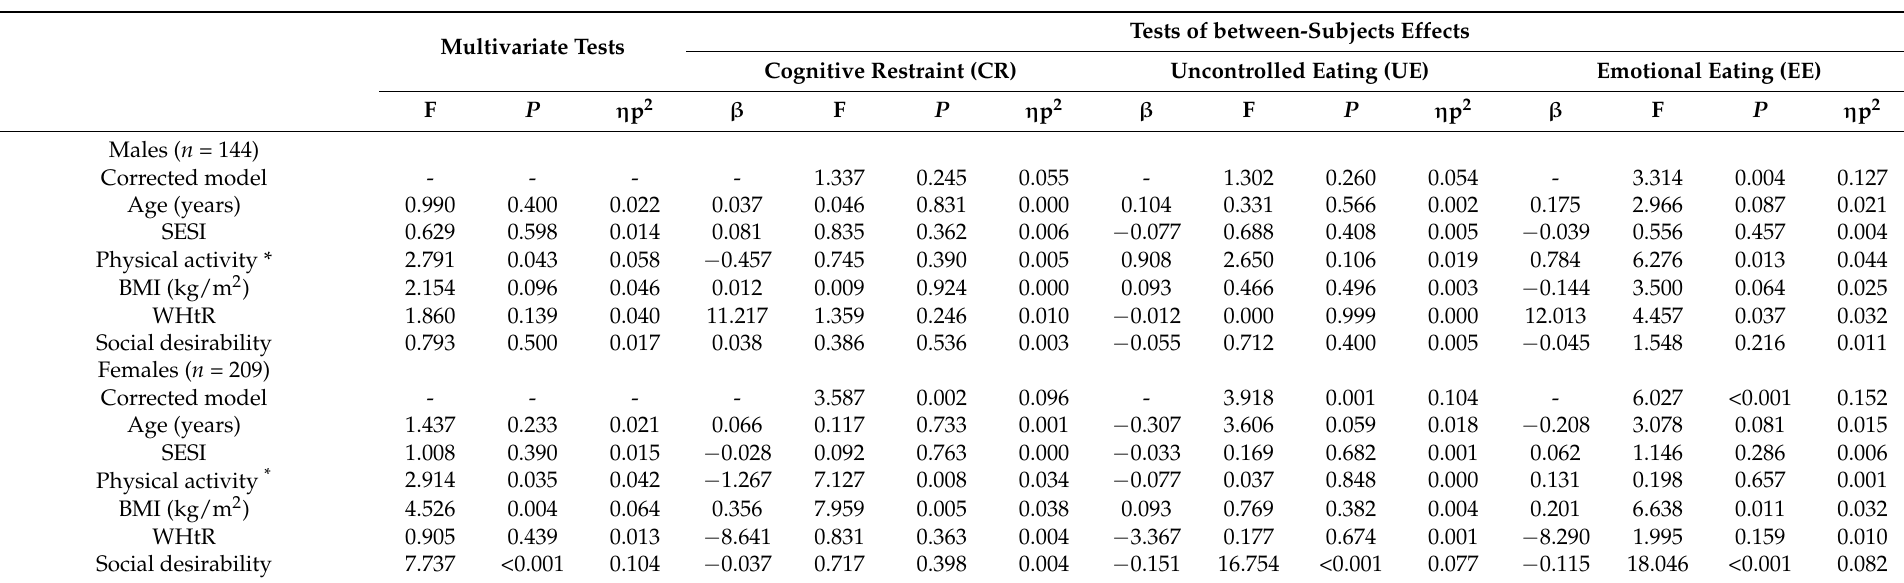
Table 3. Effects of age, SESI, physical activity, BMI, WHtR, and social desirability on eating behaviour dimensions among males and